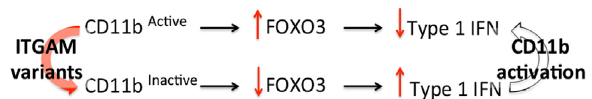
FigURe 2 | CD11b modulates toll-like receptor-induced type I interferon (IFN-I) pathway. A schematic showing the working model of how inactive CD11b due to ITGAM single nucleotide polymorphisms (SNPs) results in a deficit in the FOXO3-mediated IFN-I pathway, which can be reversed with pharmacological activation of CD11b via leukadherin-1